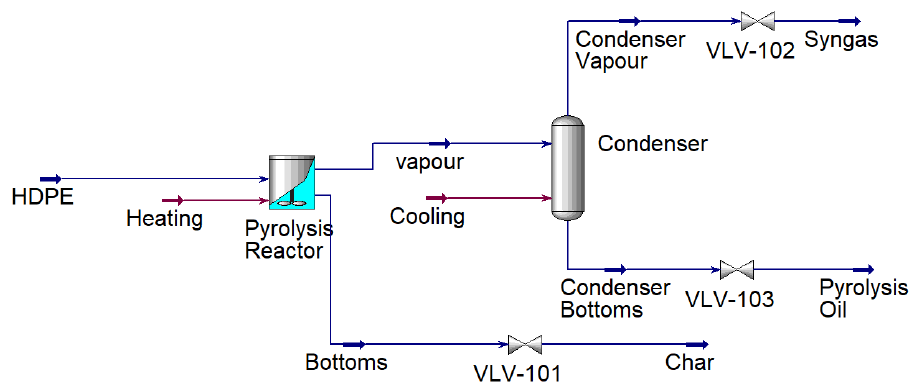
Figure 2. Aspen HYSYS process flow diagram for the steady-state simulation of HDPE to fuel via pyrolysis. via